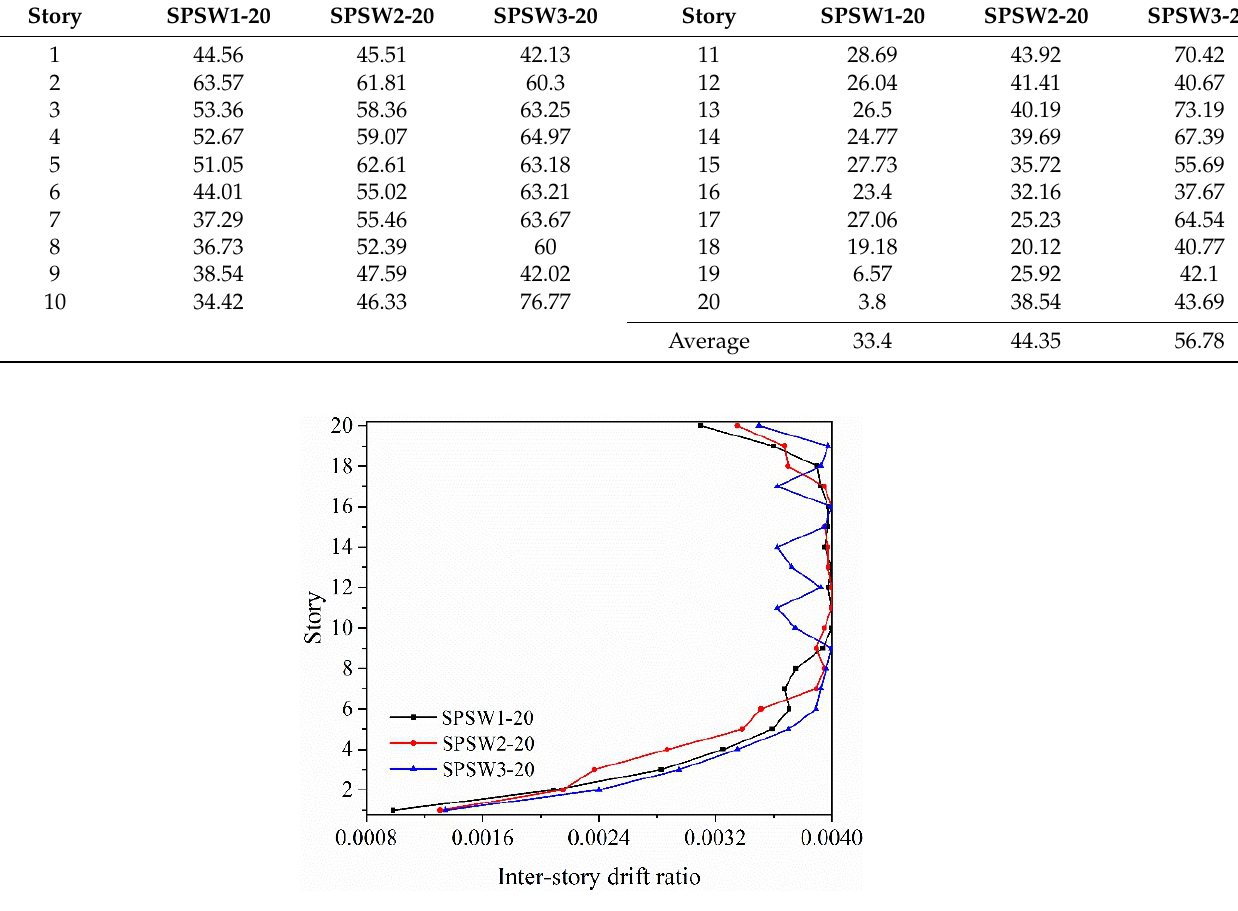
Figure 16. Inter-story drift ratio for optimum designs of 20-story steel frame. Table 13. Maximum and average stress ratios of frame and plate elements for the 20-story steel frame.